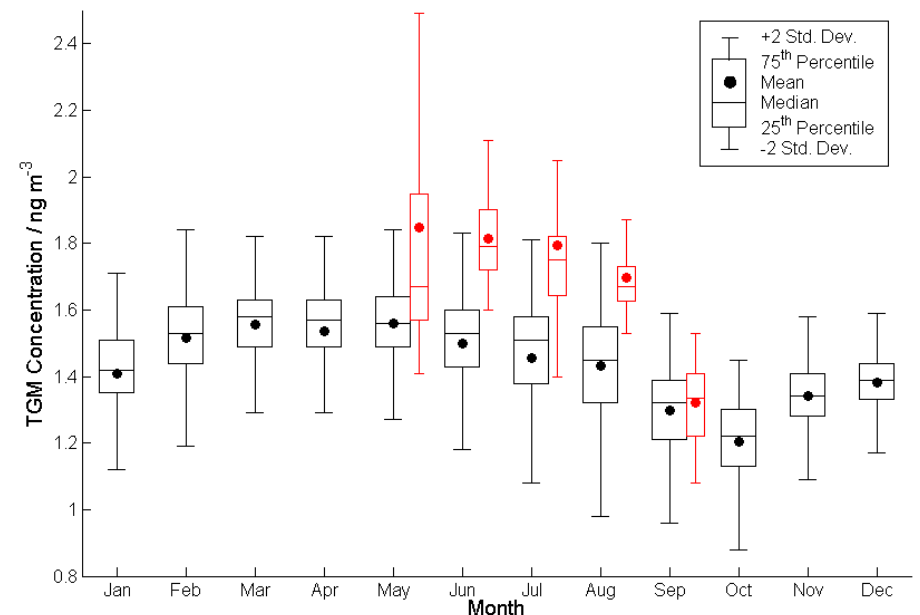
Figure 2. Monthly averaged TGM concentrations measured at Patricia McInnes station. Red data are impacted by forest fire smoke, whereas black data are not.